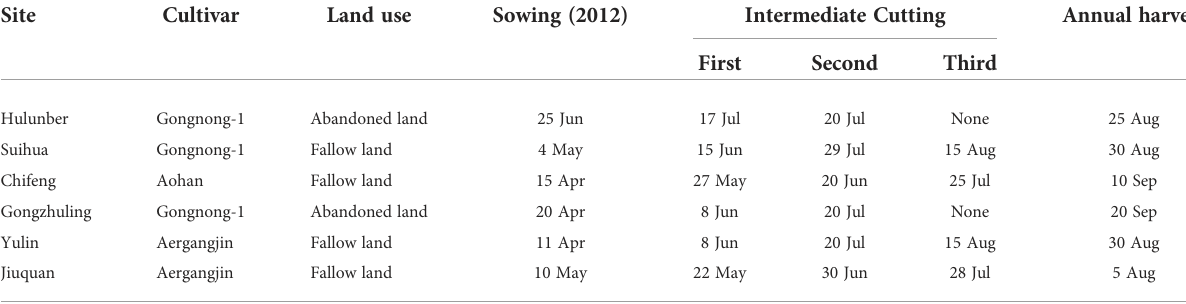
TABLE 2 The alfalfa management calendar used in the fi eld